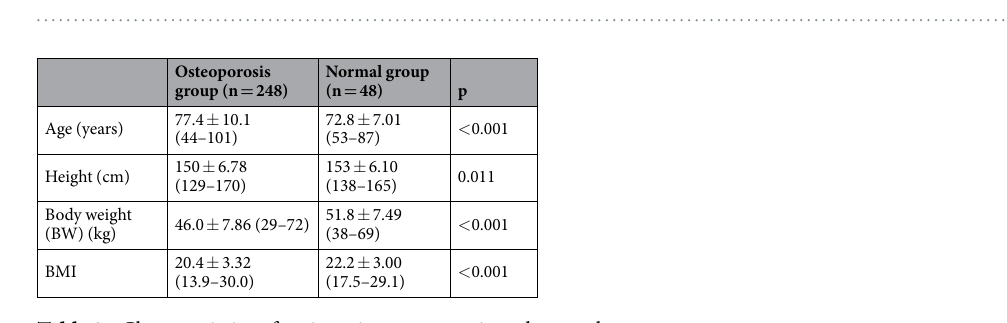
Table 1. Characteristics of patients with hip fracture group (a subgroup of the osteoporosis group) and control normal patients.